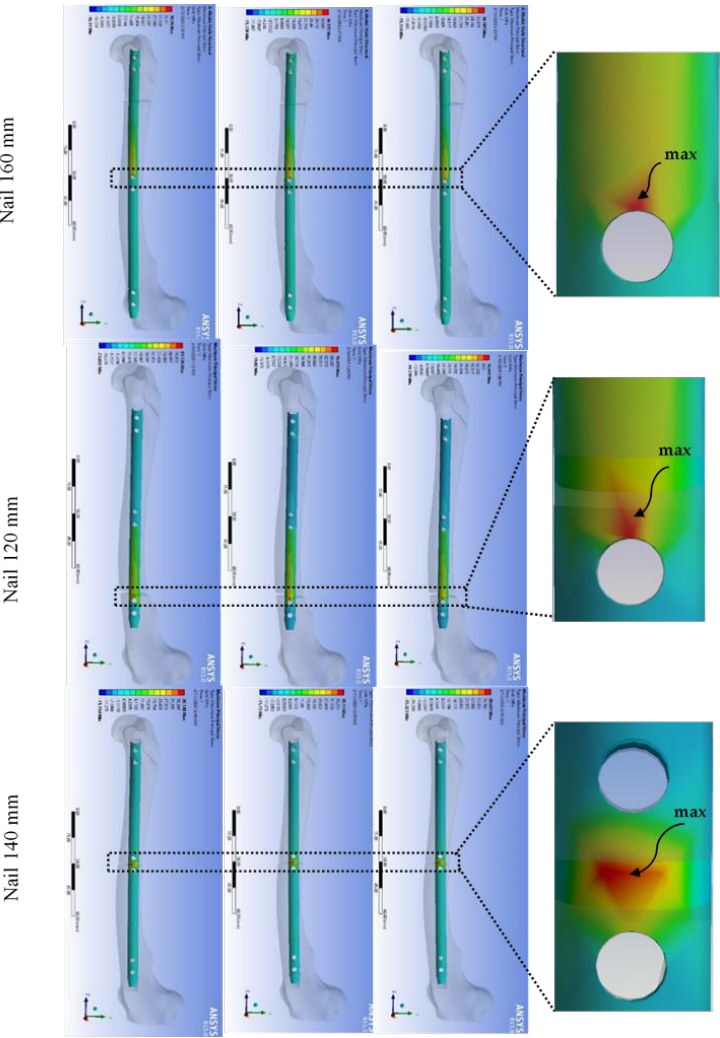
Figure 13. The maximum principal stress contours for a 1 mm proximal shaft (top row), a 3 mm distal shaft (middle row), and 2 mm middle shaft (bottom row) fractures.